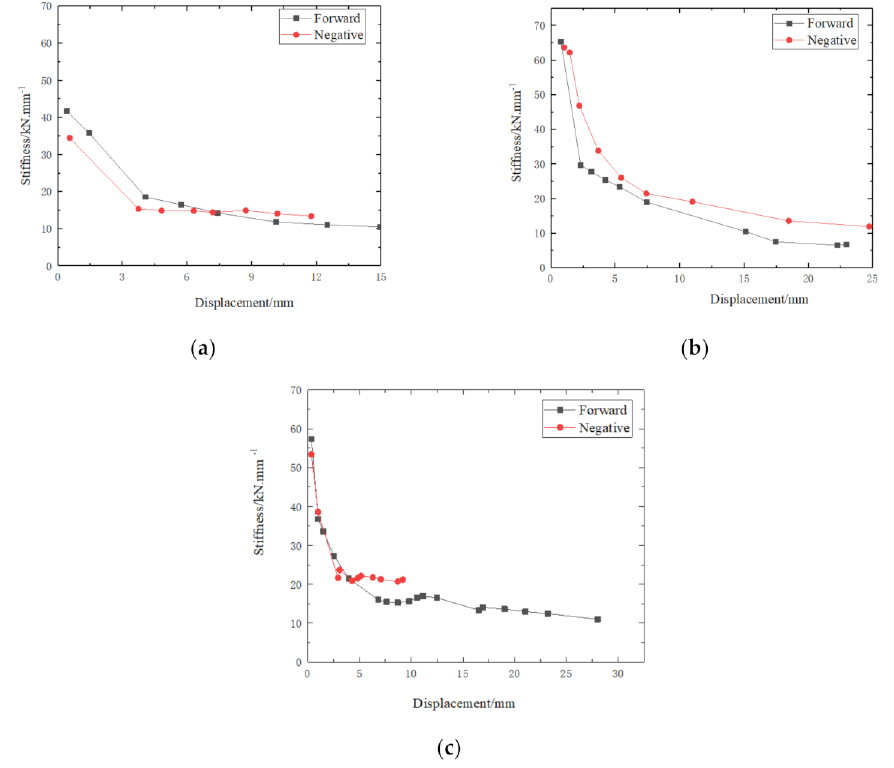
Figure 13. Stiffness degradation curve: ( a ) GD1 specimen, ( b ) GD2 specimen, and ( c ) GD3